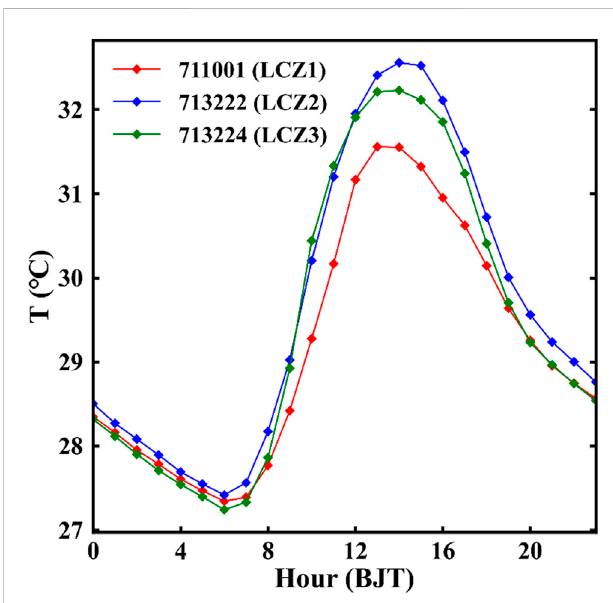
FIGURE 9 Diurnal variation of temperature at stations 711,001 (LCZ1), 713,222 (LCZ2), and 713,224 (LCZ3) (BJT: Beijing